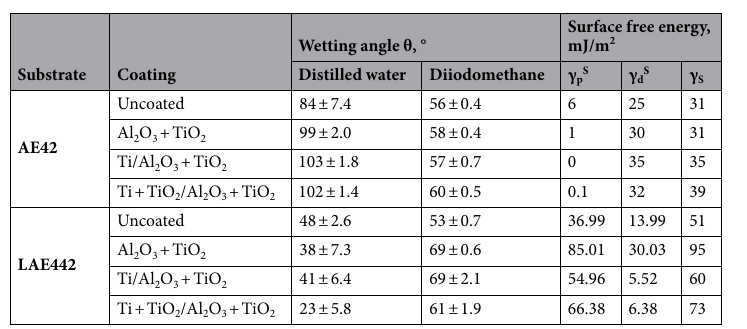
Table 5. The contact angle measurements and the surface energy calculated by the Owens–Wendt method.